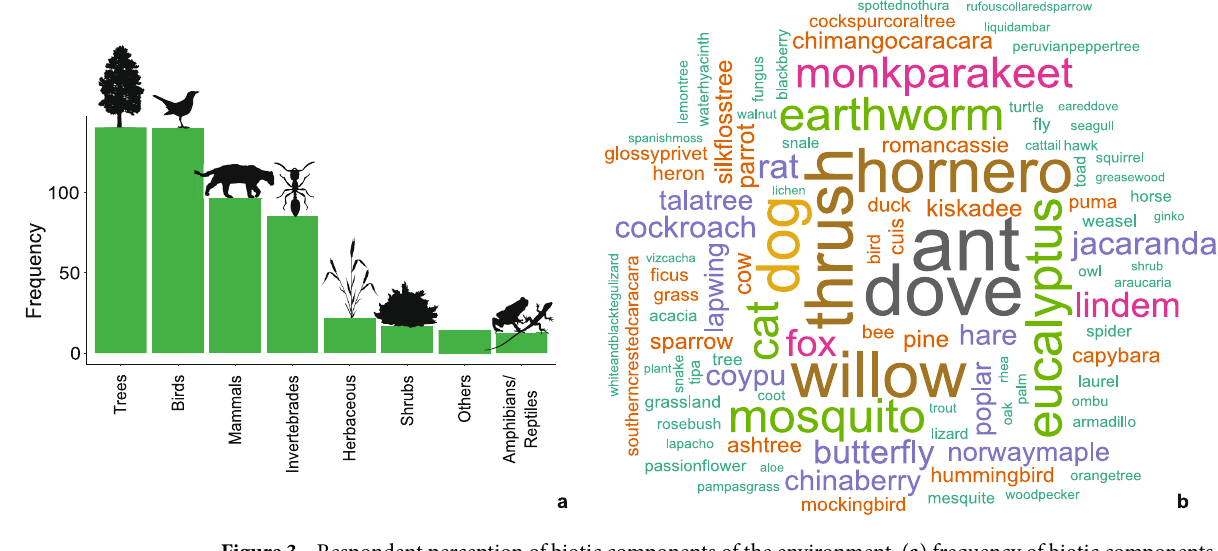
Figure 3. Respondent perception of biotic components of the environment, ( a ) frequency of biotic components listed by respondents grouped in eight categories, ( b ) word cloud of listed biotic components by respondents. Bigger letter size implies more frequency of presence in replies.